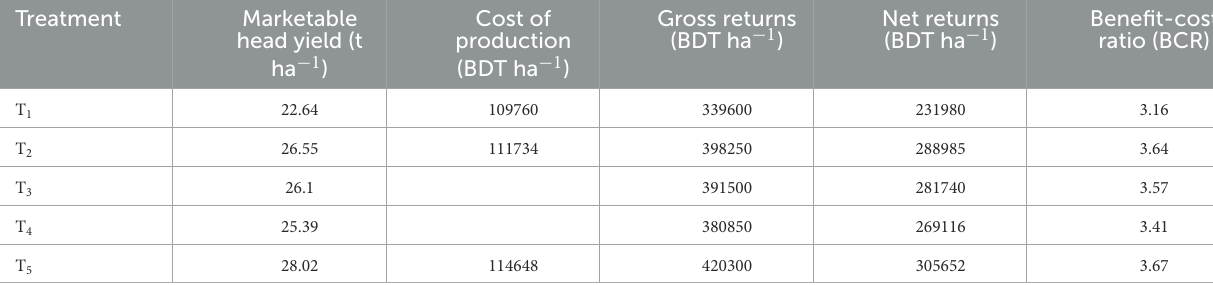
TABLE 8 Economic performance of broccoli production by pre-harvest foliar application effects of mineral nutrients.